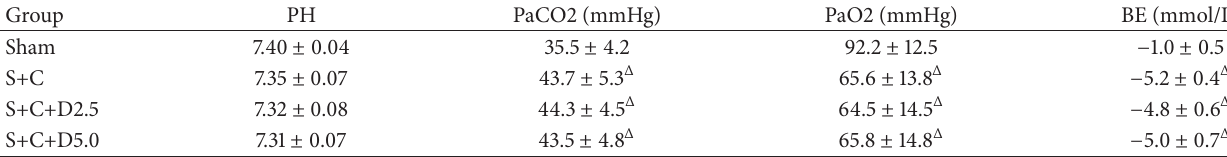
Table 2: Effects of DEX administration on arterial blood gas during postpartum BMODS in rats.